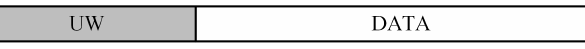
Figure 1. Traditional TDMA frame